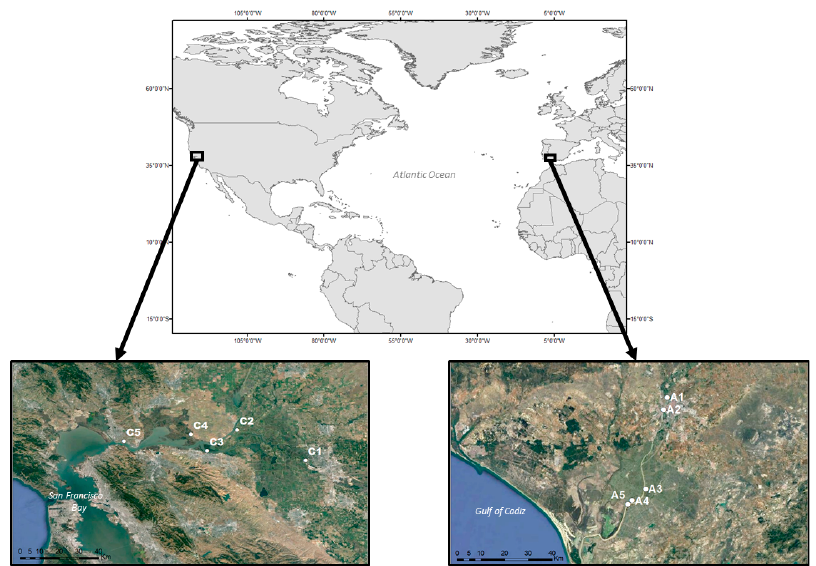
Figure 1. Location map of study locations of Iris pseudacorus in the native range (Guadalquivir River Estuary, Andalusia, Spain, A1–A5) and the invaded range (Sacramento-San Joaquin Delta, California, USA, C1–C5). Source: Google Earth 2020 (accessed on 1 July 2021).